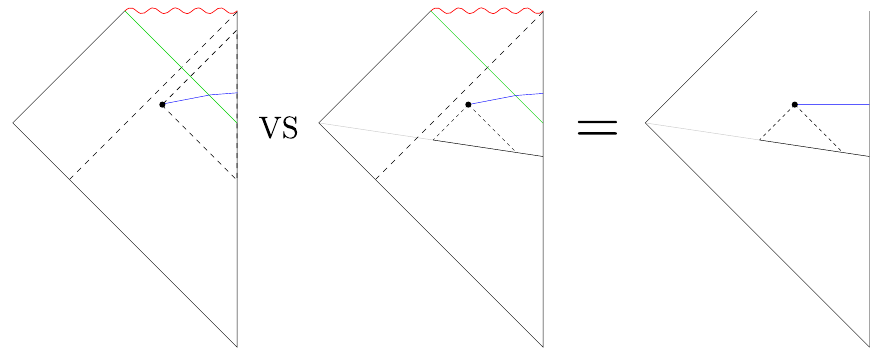
Figure 11 . Two methods of implementing the HKLL perscription for an operator in region I. One can either implement the usual HKLL directly by (cid:12)nding the spacelike Green’s function in the Vaidya geometry (left), or by evolving the operator using a retarded Green’s function (cid:12)tting the operator entirely in region I (right). The operator can then be obtained by evolving forwards using H . The equality on the right is equation